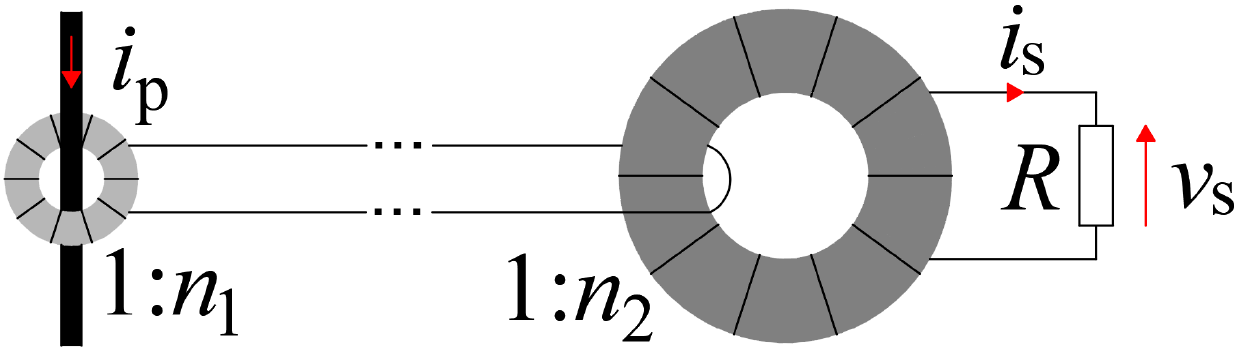
Figure 1. The concept of dual HFCTs and burden resistor R .